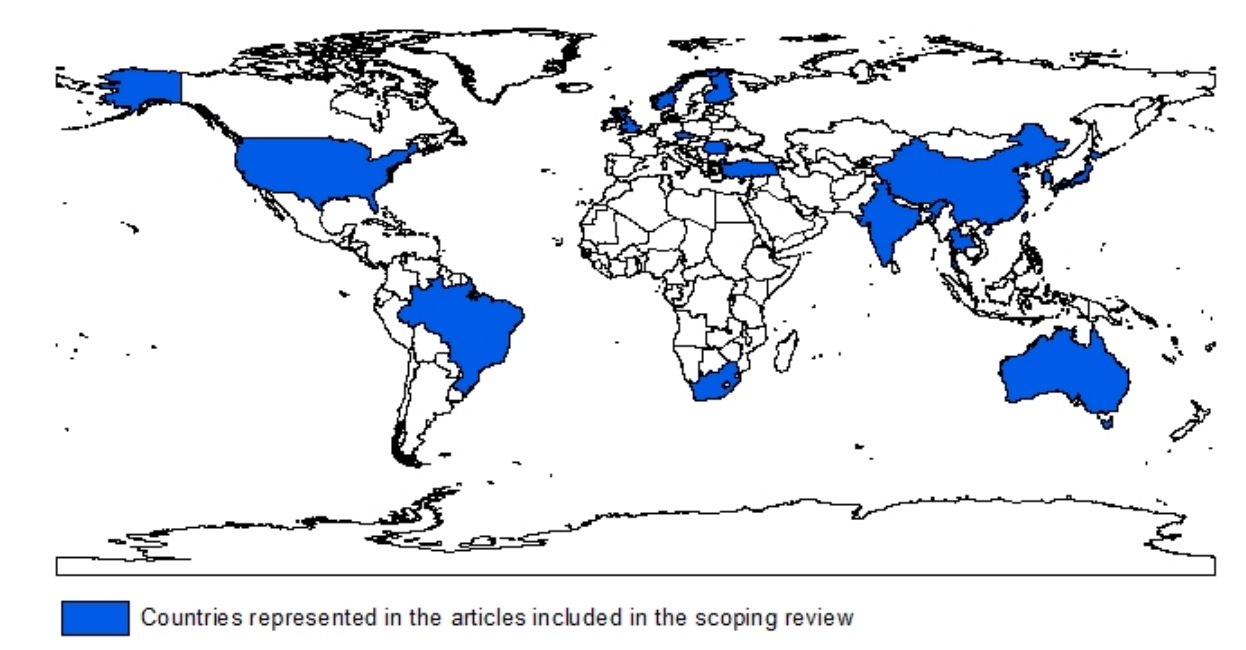
Figure 2. Global incidence of silicosis in the journal articles included in the scoping review.